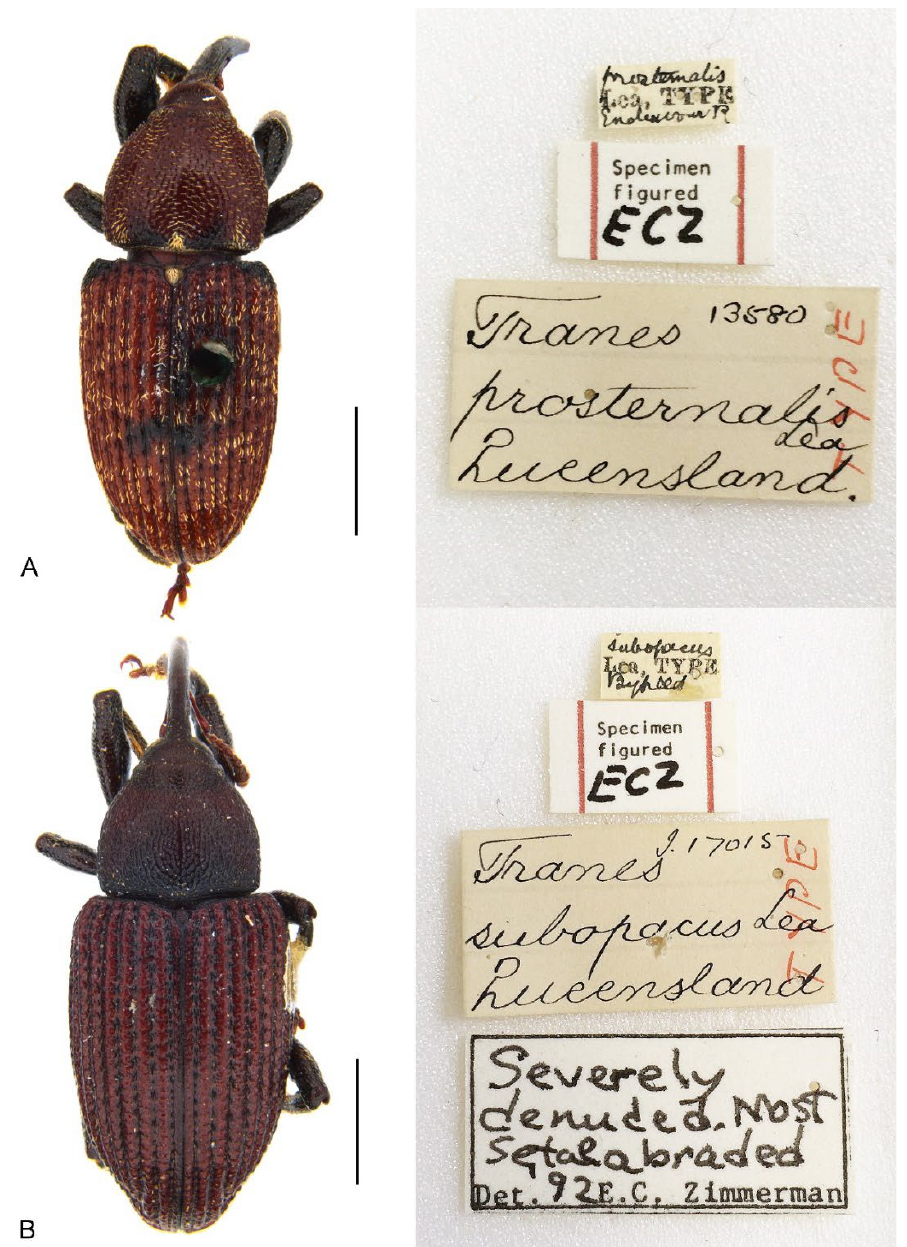
Figure 13. Name-bearing types of Miltotranes : ( A ) Tranes prosternalis Lea, 1929, lectotype; ( B ) Tranes subopacus Lea, 1929, holotype. Scale bar: 2.0 mm.